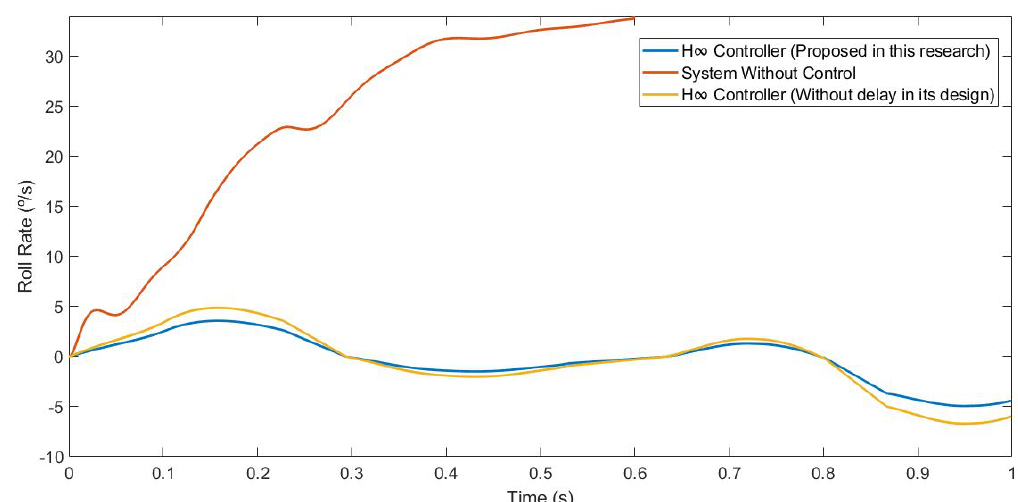
Figure 20. Roll rate for test 3: Roundabout at 120 km/h.